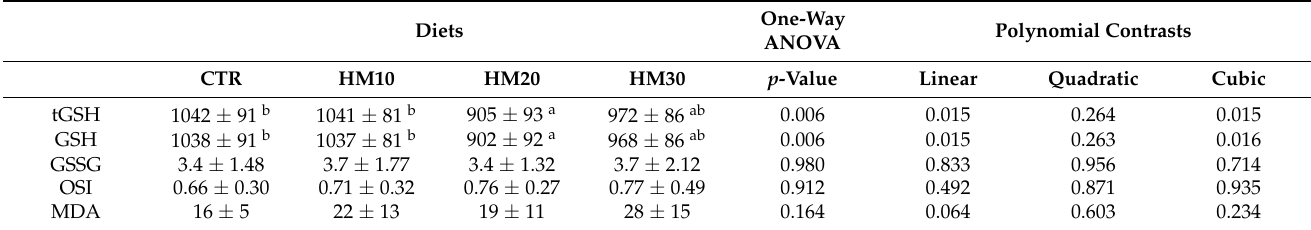
Table 2. Hepatic levels of total glutathione (tGSH), reduced glutathione (GSH), and oxidized glu- nmol malondialdehyde g tissue − 1 ) in meagre juveniles fed the experimental diets with different levels of Hermetia meal